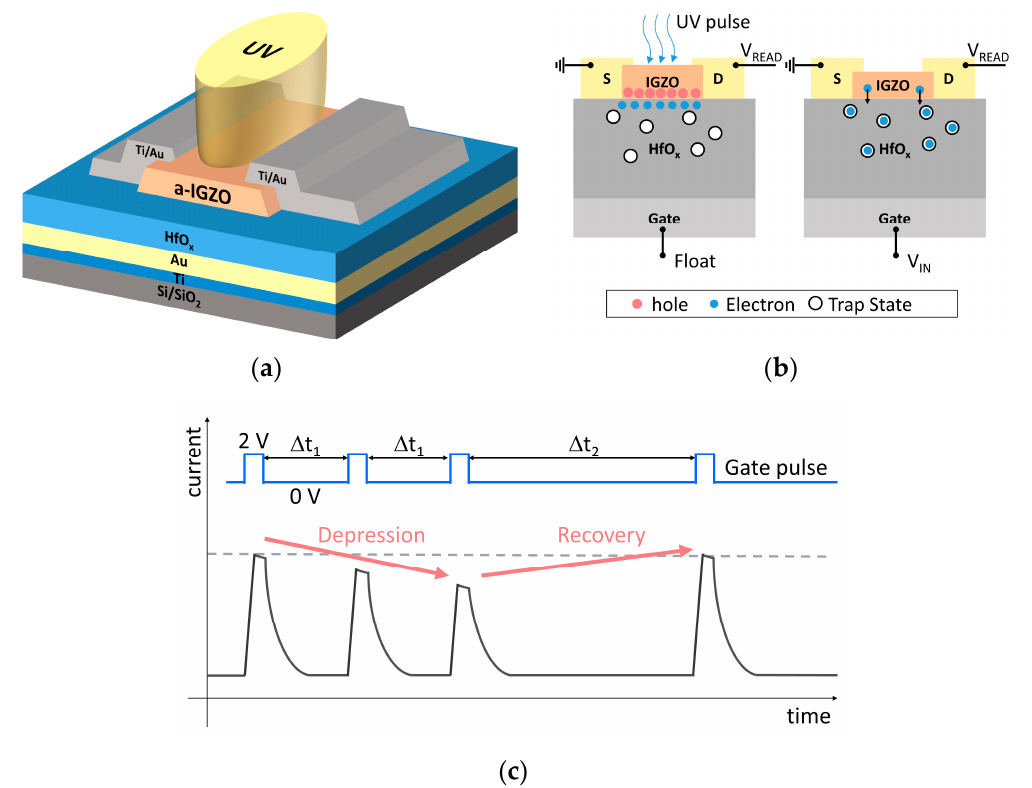
Figure 7. ( a ) Device structure. ( b ) Conceptual diagram of device operating under light pulse ( left )